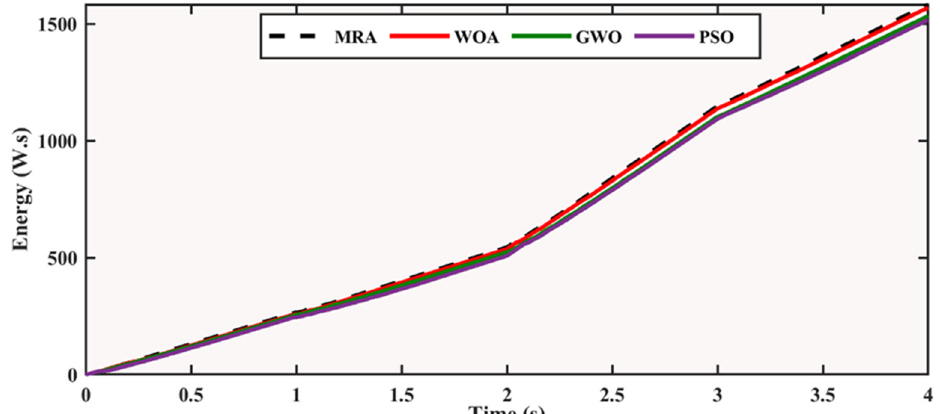
13 of 19 Figure 10. Comparative analysis of all techniques for Case 2 (a) Duty Cycle Variation (b) Power Tracking (c) Current Variation Table 2. Comparative analysis for Case 2. Tech.